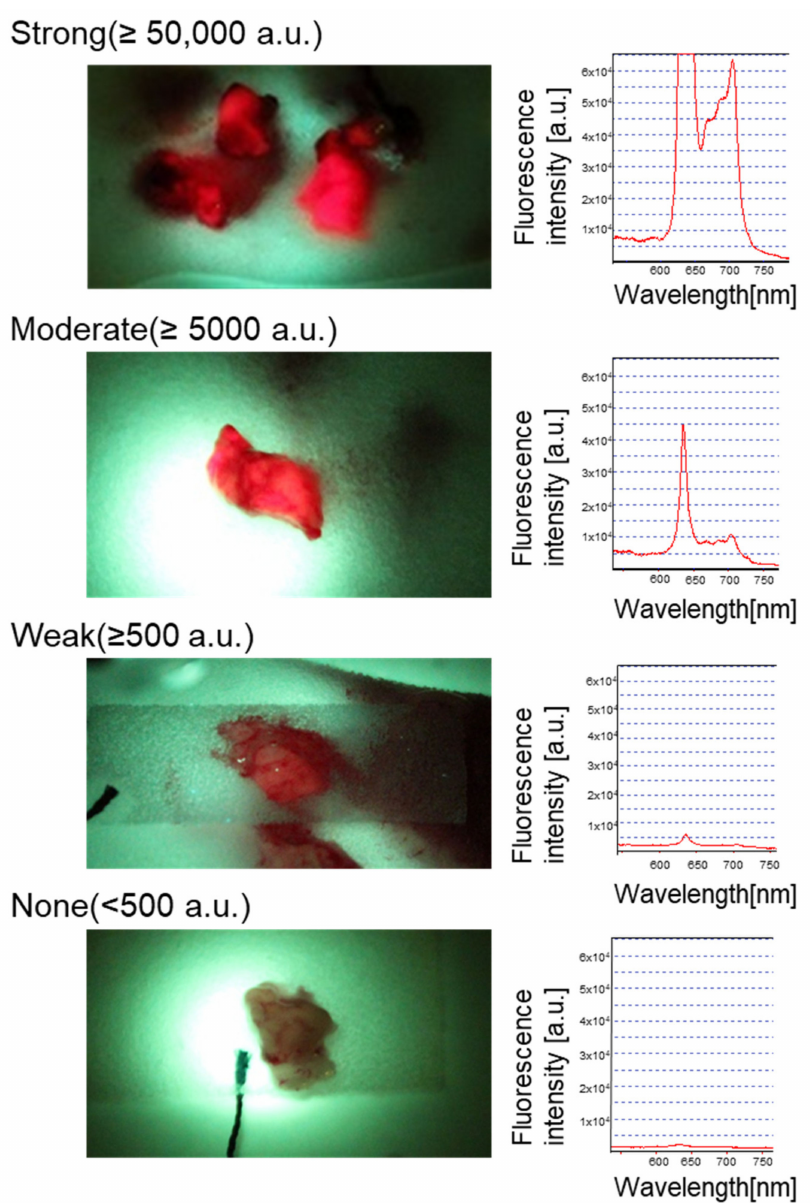
Figure 1. Quantification of intraoperative 5-ALA-induced fluorescence intensity from resected tumor